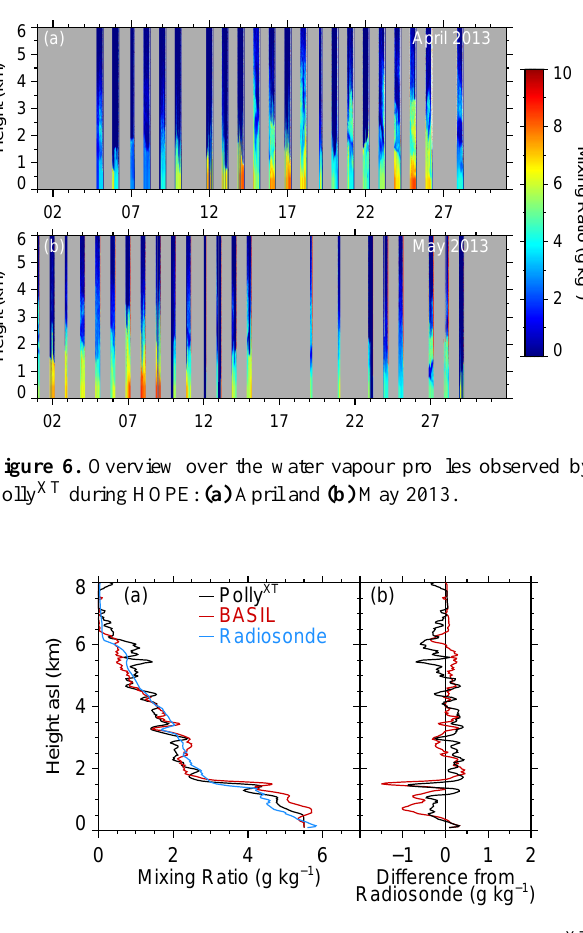
Figure 7. (a) Comparison of the mixing ratio profiles from Polly XT (black), BASIL (red) and radiosonde (blue) on 5 May 2013, 23:00UTC. The lidar profiles are averaged over 20min. (b) Differ- ences in mixing ratio between radiosonde and Polly XT or BASIL, respectively.